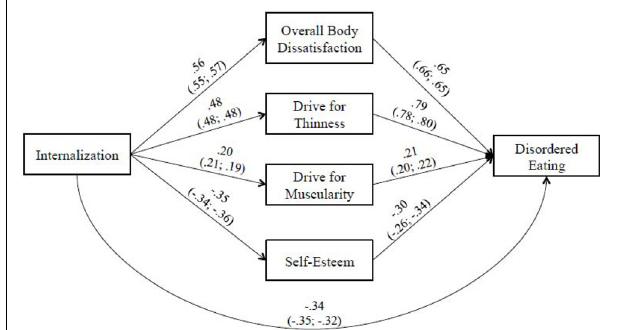
FIGURE 2 | Model of the relationship between internalization of socio-cultural standards of beauty and disordered eating for women. Revised model with significant paths added. Path coefficients for the full sample of women as well as for the sub-samples of heterosexual (right side) and gay/bisexual women (left side) are presented (all p s <